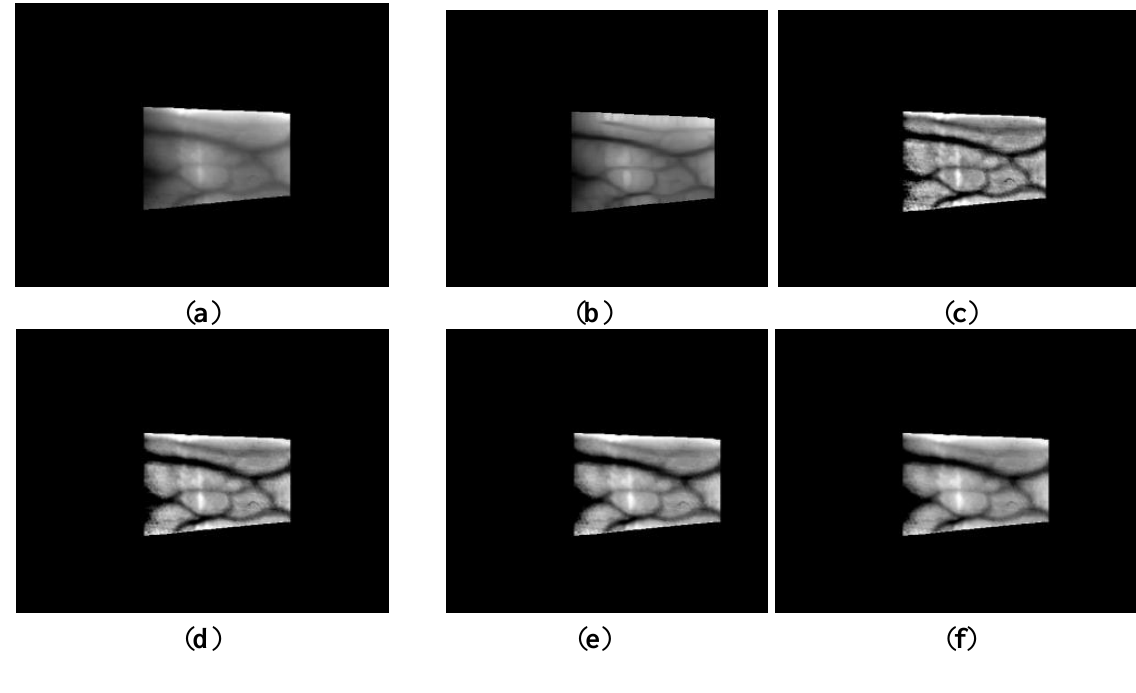
Figure 9. Comparison of outputs produced by Gabor and Retinex filtering using images from database I: ( a ) original image of the detected finger boundaries; ( b ) results with Gabor filtering; and results with Retinex filtering using sigma values of ( c ) 10, ( d ) 15, ( e ) 20, ( f ) 25, and ( g )